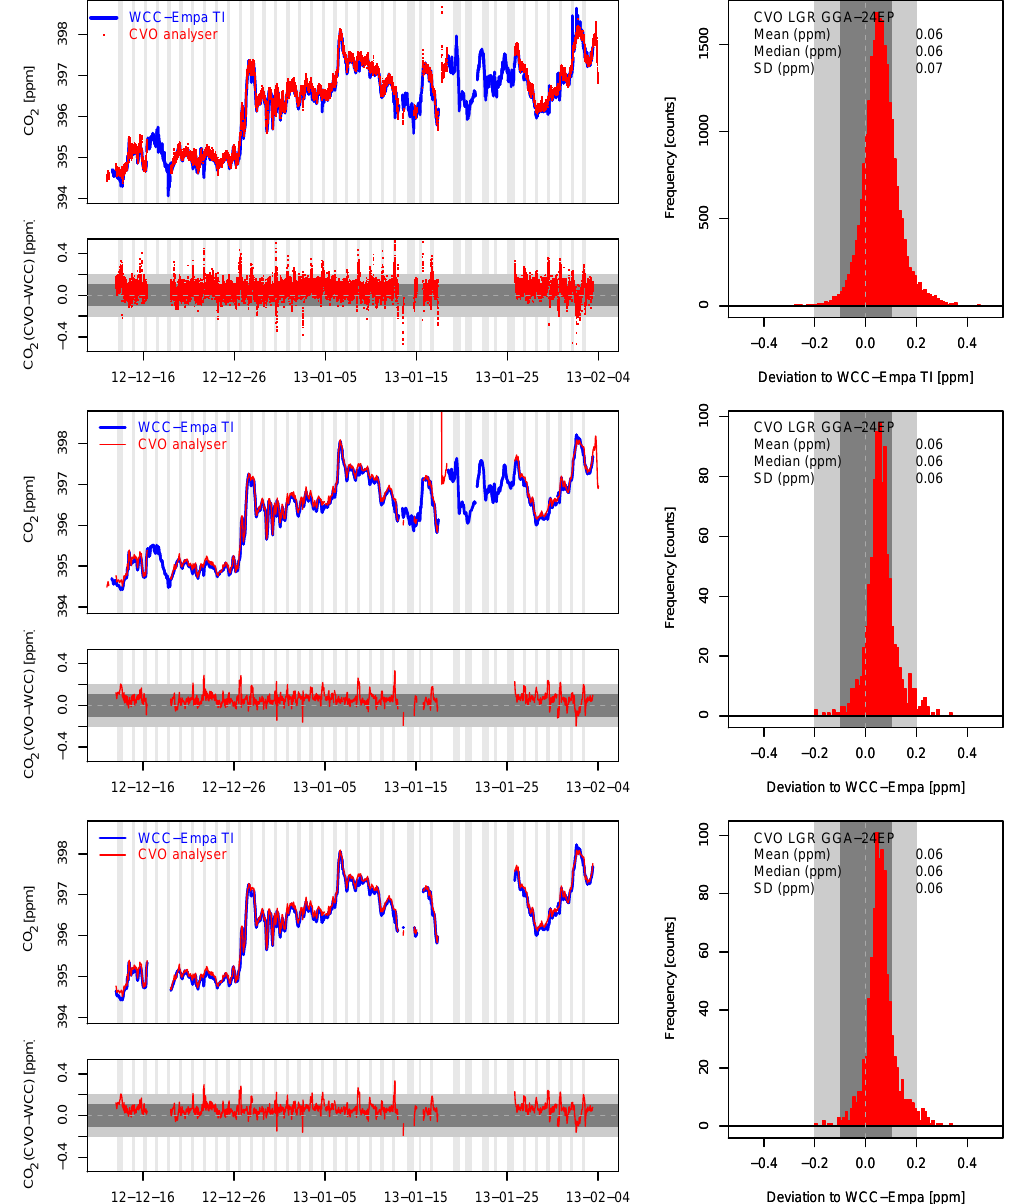
Figure 8. CO 2 comparison at CVO between the WCC-Empa travelling instrument and the CVO LGR GGA-24EP instruments. Left: CO 2 time series and CO 2 bias vs. time. Right: deviation histogram. Upper set: 1min data; middle set: 1h data, calculated from all available 1min values; lower set: 1h data, calculated from 1min values with concurrent CVO and WCC-Empa data from both inlets. The grey areas correspond to the WMO/GAW compatibility (dark grey) and extended compatibility (light grey) goals; vertical grey bars (left diagrams) illustrate when different inlets were used (see text for